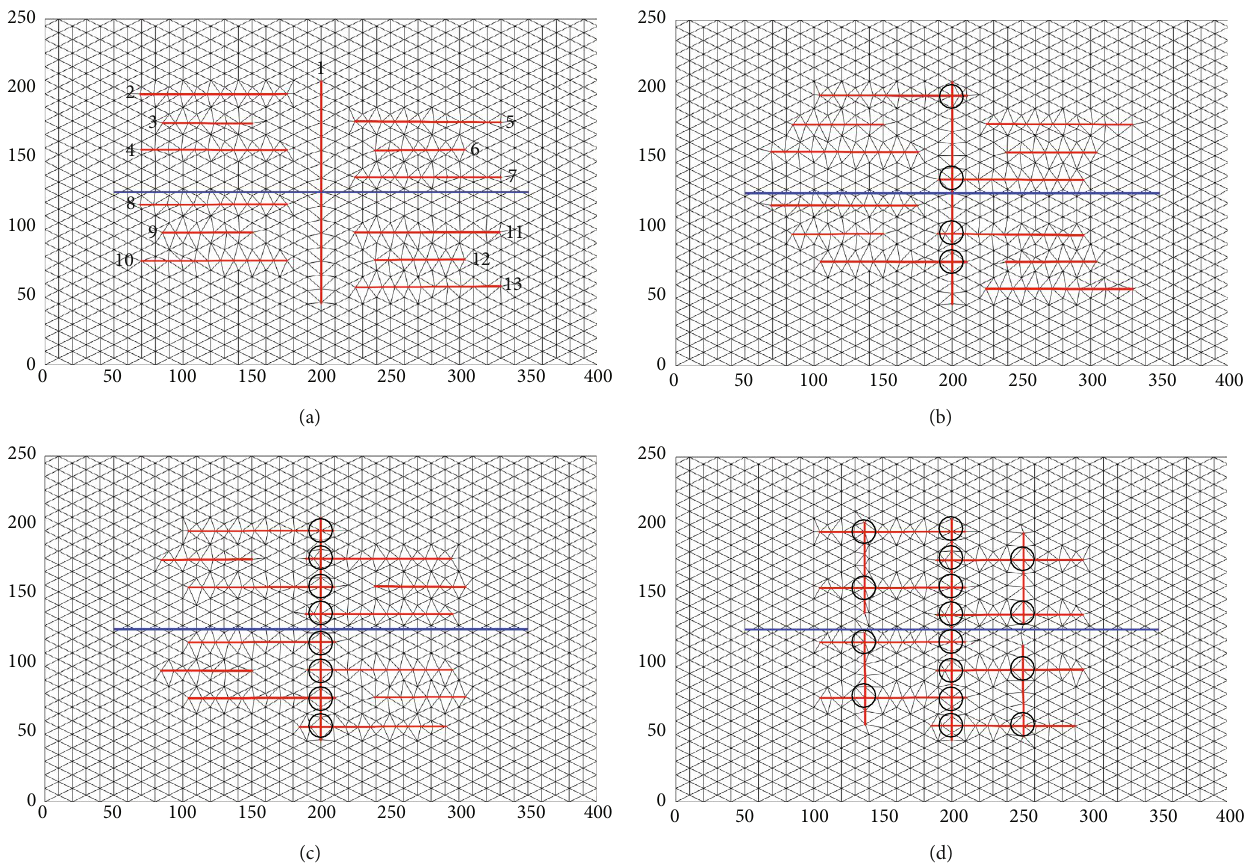
Figure 6: Grids with di ff erent fracture connectivity: (a) FC = 0 ; (b) FC = 0 : 15 ; (c) FC = 0 : 31 ; (d) FC = 0 : 62